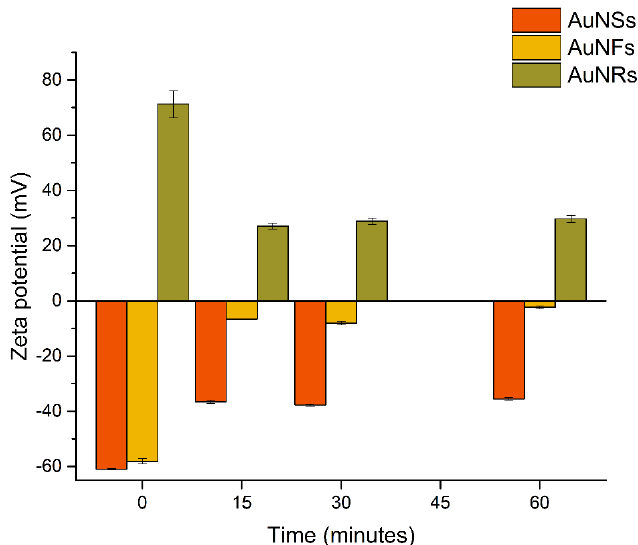
Figure 4. Zeta potential values of AuNPs before and after incubation with saliva samples.